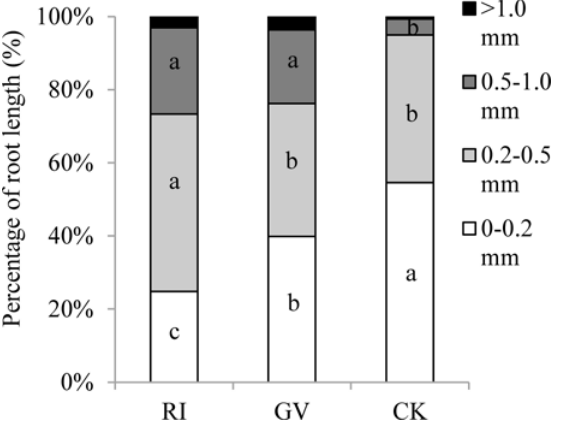
Fig 1. Percentage of root length in different diameter classes measured in R . pseudoacacia roots colonized by R . irregularis (RI), G . versiforme (GV) or not (CV). Significant differences are indicated by different letters (one-way ANOVA with Fisher ’ s LSD; P = 0.05; n = 6). Replicate data is from S1 Dataset.